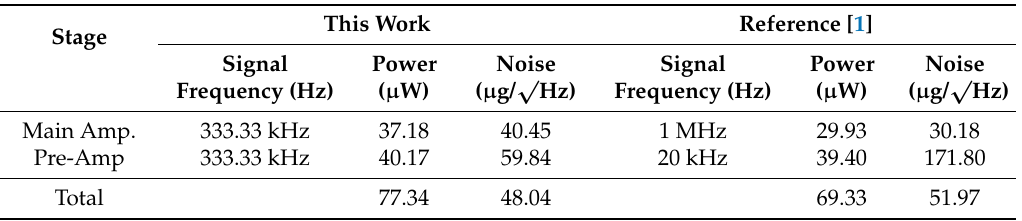
Table 2. Analysis and comparison of noise and power at the two stages.